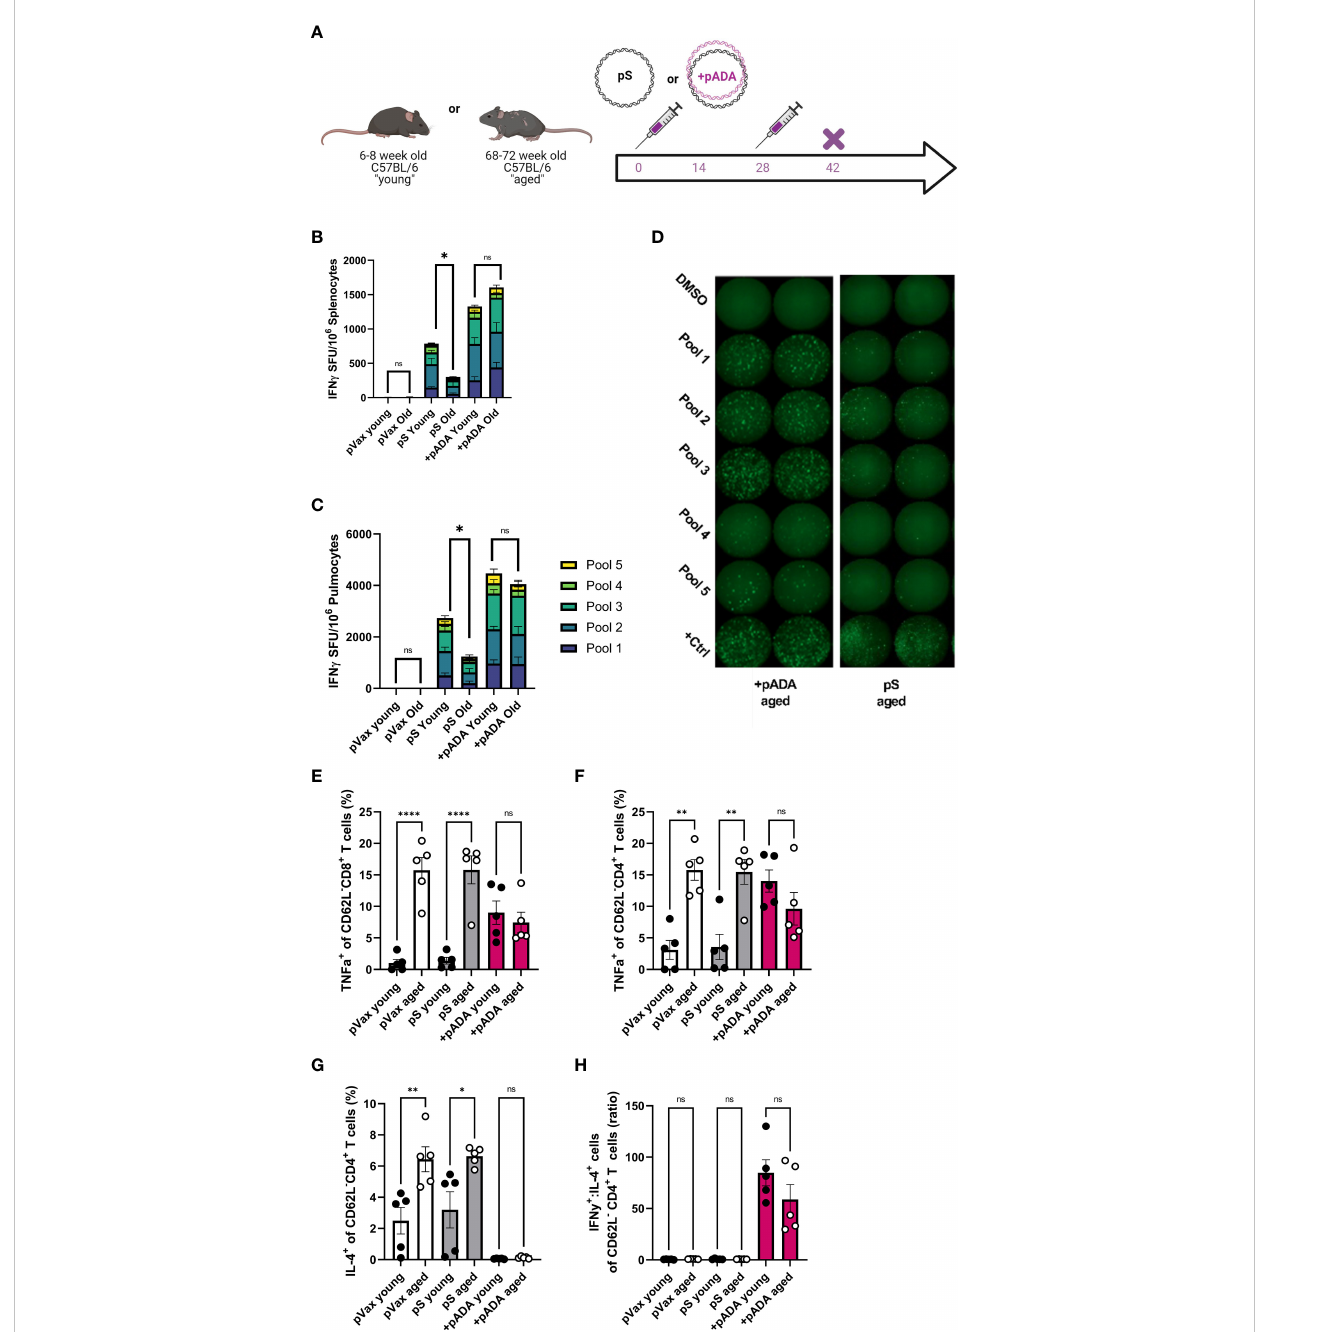
FIGURE 2 pADA co-immunization supports enhanced antigen-speci fi c effector function and inhibits age-associated in fl ammatory cytokine secretion. Mice were immunized with 10ug of spike-encoding plasmid DNA (pS) or co-immunized with 10ug od pS and 10ug of DNA plasmid encoding mouse adenosine deaminase (+pADA) twice, separated by four weeks and cellular responses were evaluated at day 14 post-second immunization (A) . Interferon gamma spot- forming units in spleens (B) and lungs (C) ; representative IFN g wells (D) as measured by ELISpot assay. Frequency of TNF a + CD8 + (E) and CD4 + T cells in spleens (F) . Frequency of IL-4+ CD4 + T cells (G) , and the ratio of IFN g + to IL-4 + CD8 + T cells (H) . Data are representative of three independent experiments with N=5 per group (B, C) or one experiment with N=5/group (E – H) . Symbols represent individual animals, bars represent the mean, error bars represent the standard deviations. ns, not signi fi cant. *P<0.05, **P<0.01, and ****P<0.0001 by Mann-Whitney-U